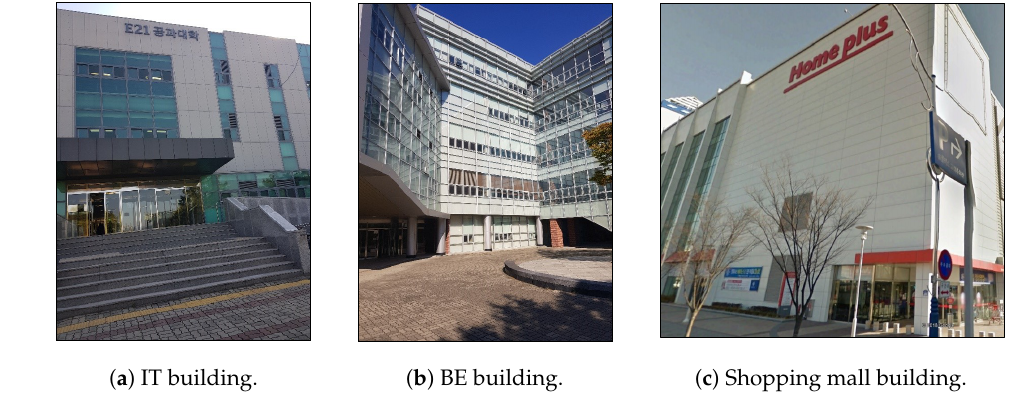
Figure 14. Buildings used in the experiment. Table 4. List of the sensors used for the